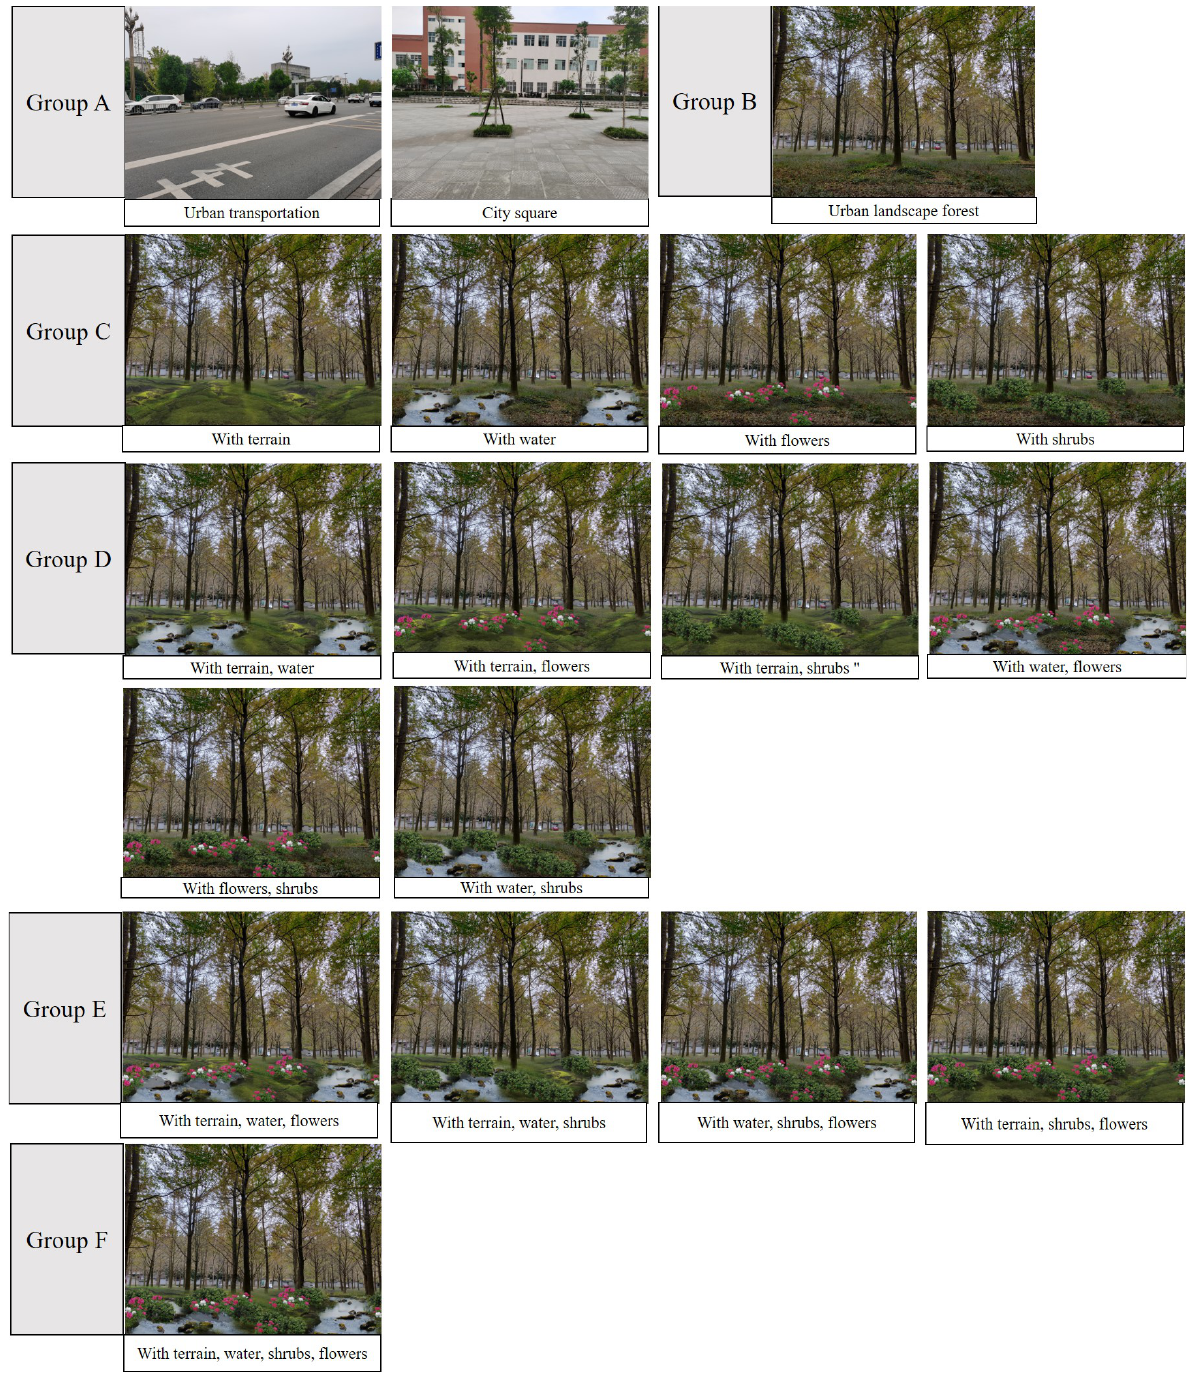
Figure 1. The eighteen images for experimental visual stimulation .